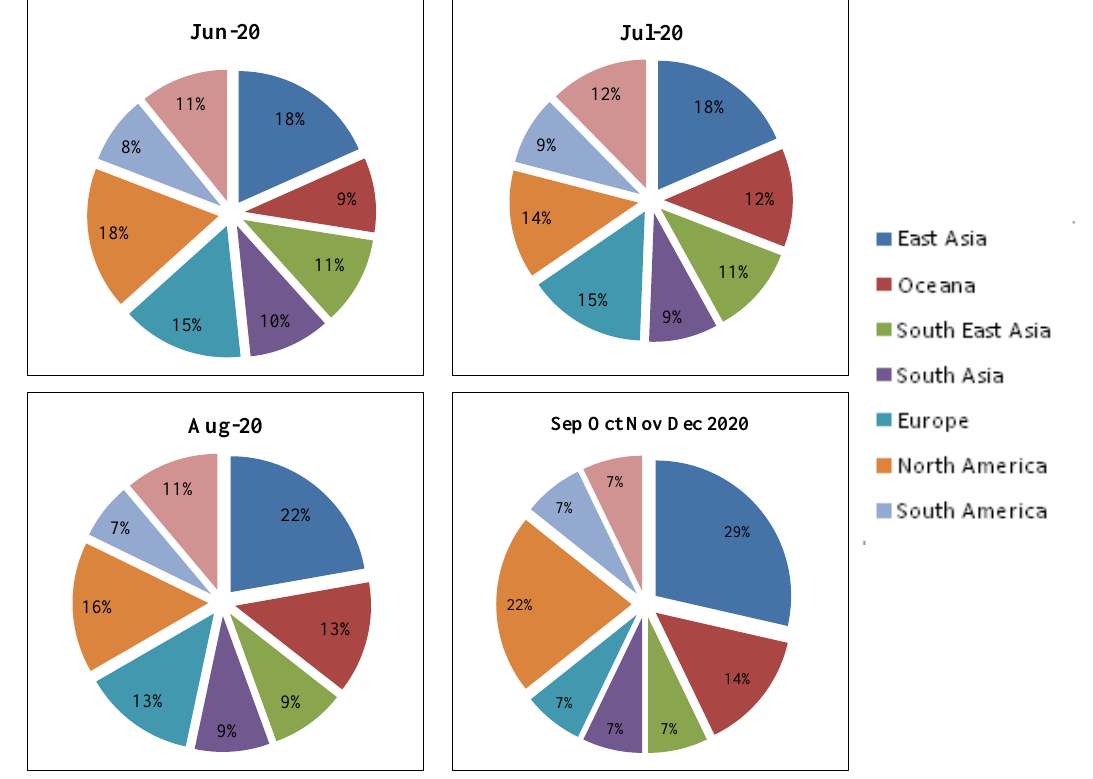
Figure 9. Regions used for Research Study in Months/Periods of